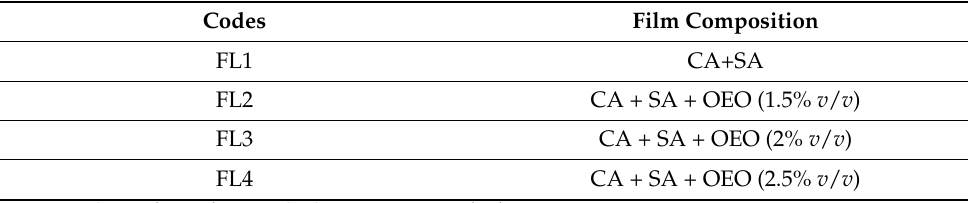
Table 1. Composition of the OEO-loaded CA–SA-based composite films.